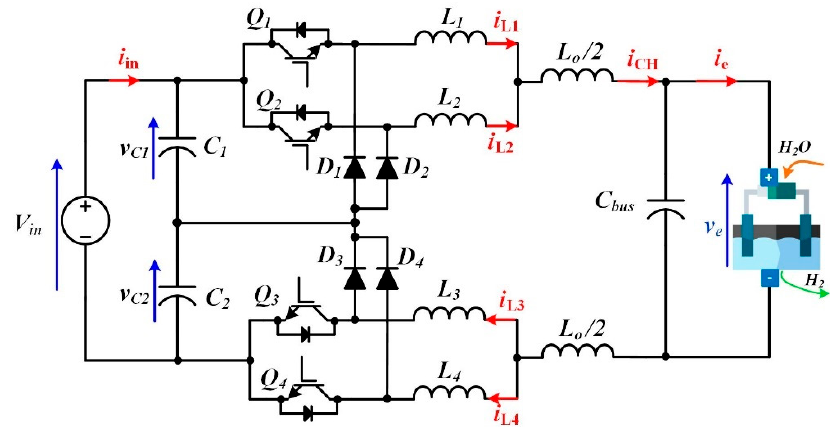
Figure 1. Three-level interleaved buck converter investigated in this work.